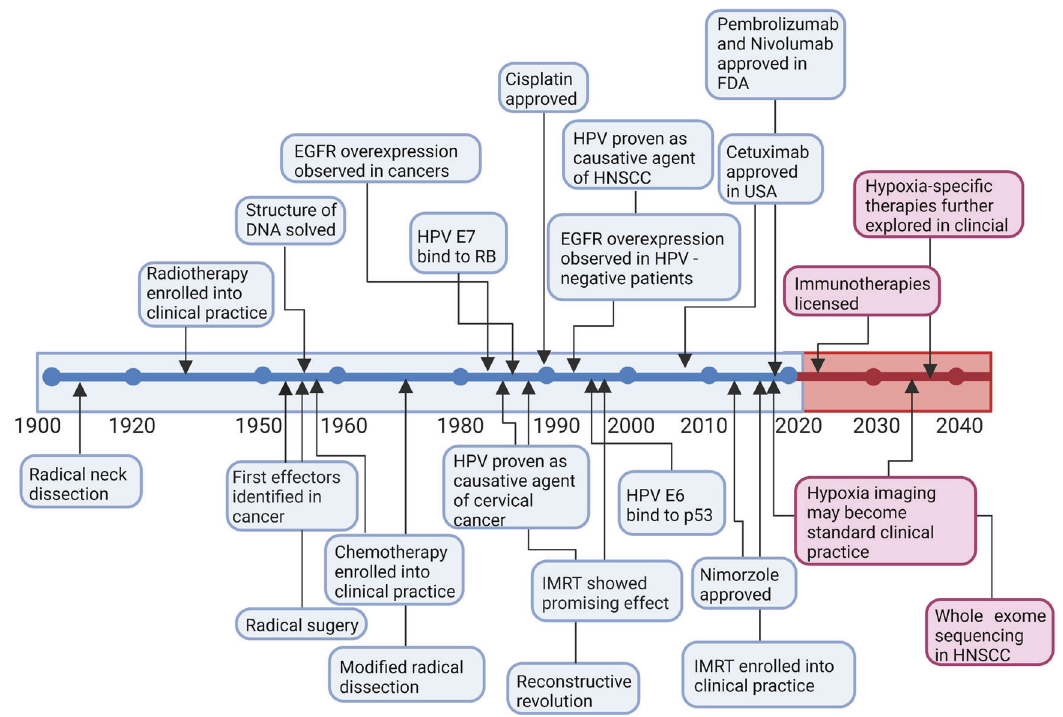
Fig. 1 Timeline of treatment regimens and targeted therapy development in head and neck cancer and further investigation. Early on, surgery was fi rst used to treat head and neck cancer. With further investigation, more therapies have been used to treat head and neck cancer. In the 1980s, an advanced understanding of HNSCC was made, and some major discoveries were made between the 1980s and 2020s. The prognosis of head and neck cancers was slightly improved but unsatisfactory. Some discoveries might fi rst be made in cancers other than head and neck cancers, and the same discoveries were identi fi ed in head and neck cancers after years. More agents were found and approved in head and neck cancers, which may dramatically improve the prognosis of head and neck cancer patients. DNA deoxyribonucleic acid, EGFR epidermal growth factor receptor, HPV human papillomavirus, HNSCC head and neck squamous cell carcinoma, FDA Food and Drug Administration, IMRT intensity modulated radiation